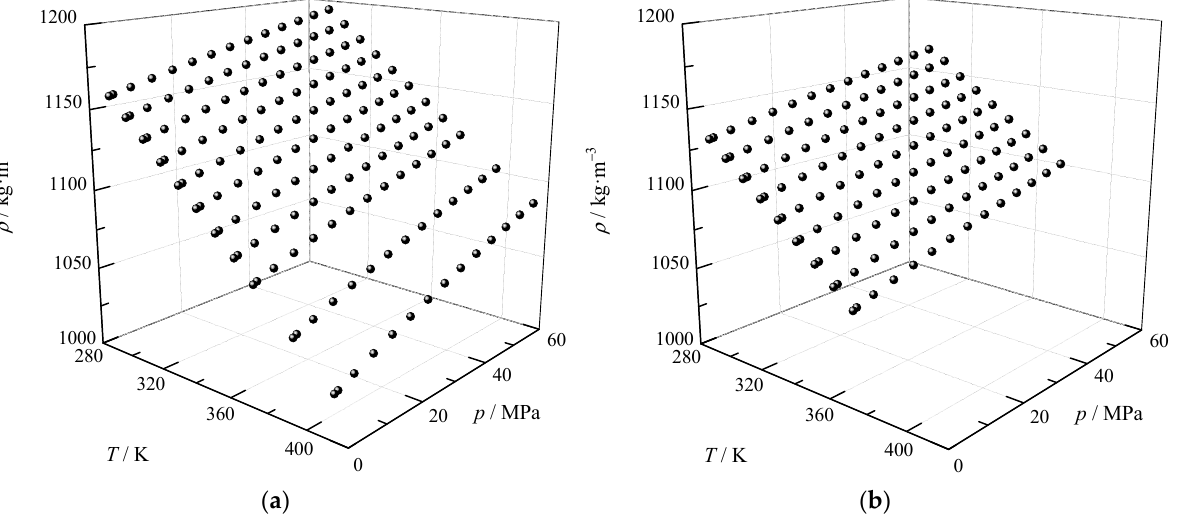
Figure 3. Density, ρ , vs. temperature, T , and pressure, p , for: ( a ) furfural and ( b ) furfuryl alcohol.